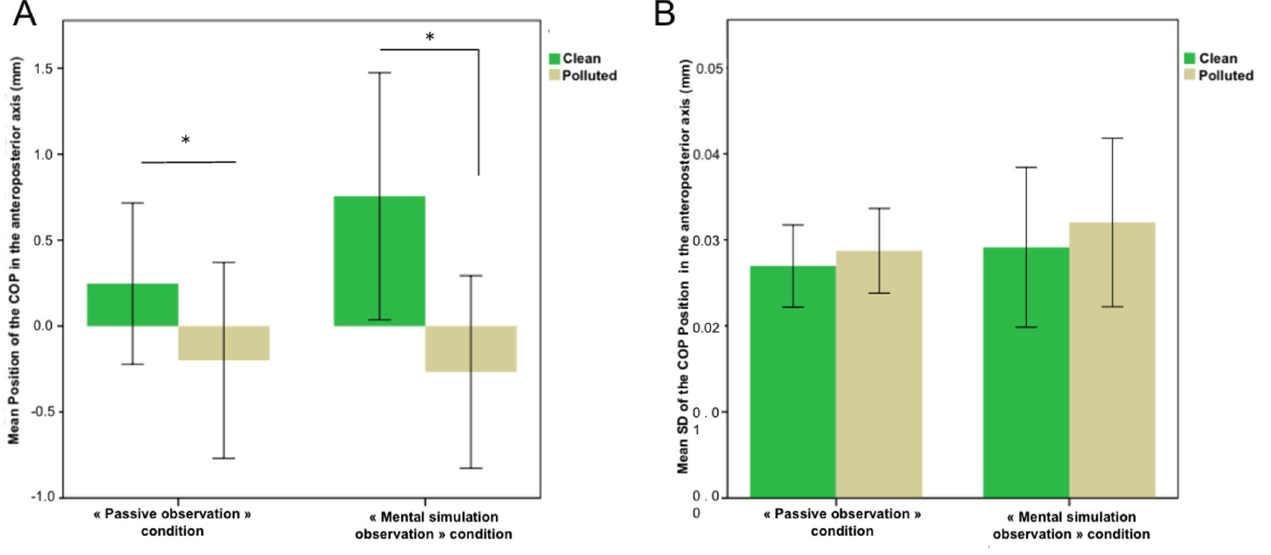
Figure 3. Mean Position ( A ) and Position’s Standard Deviation ( B ) of the COP along the anteropos- terior axis (mm) according to Passive observation condition (left side of each panel) and Mental simulation observation condition (right side of each panel). Significant differences exist for viewing a polluted scene and viewing a clean scene ( p = 0.011). * p < 0.05, means ± standard deviations.